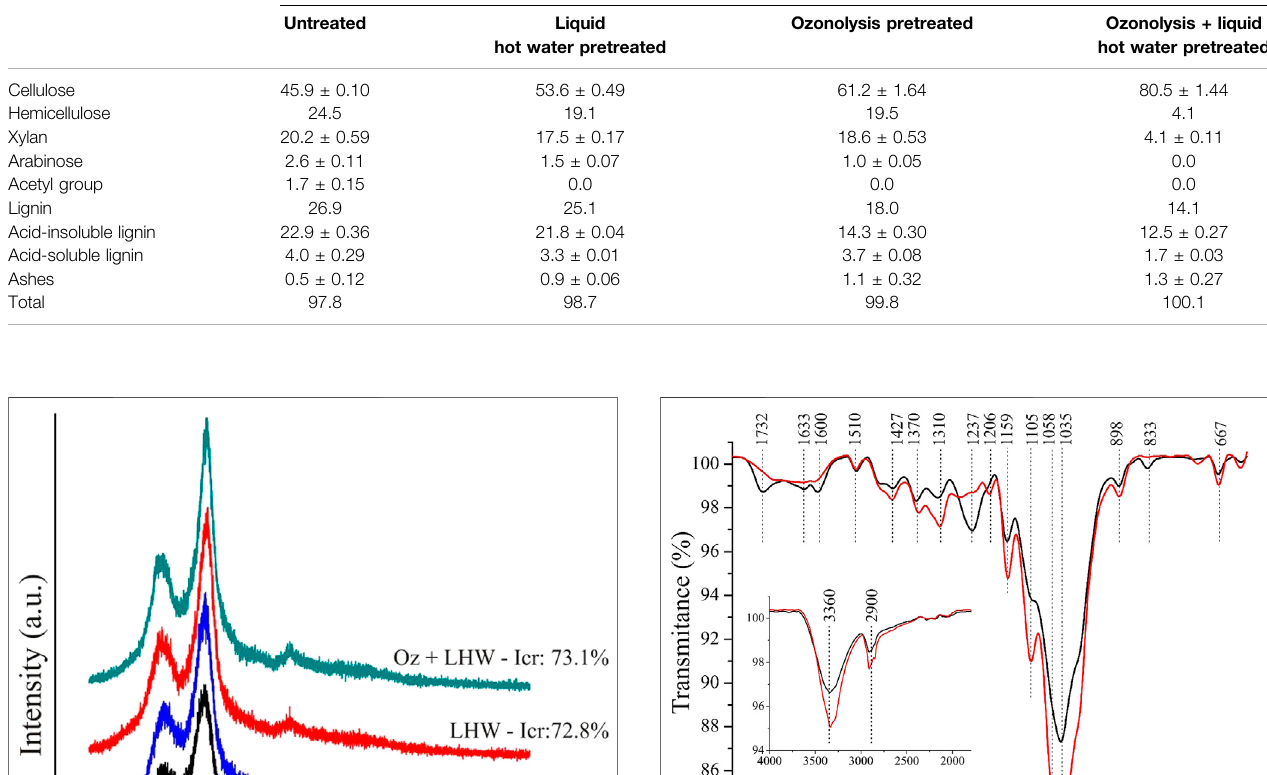
TABLE 1 | Compositional analysis of sugarcane bagasse generated by different pretreatment approaches and the untreated sample. Solid composition is presented as dry weight on a free extractive basis (%). Component